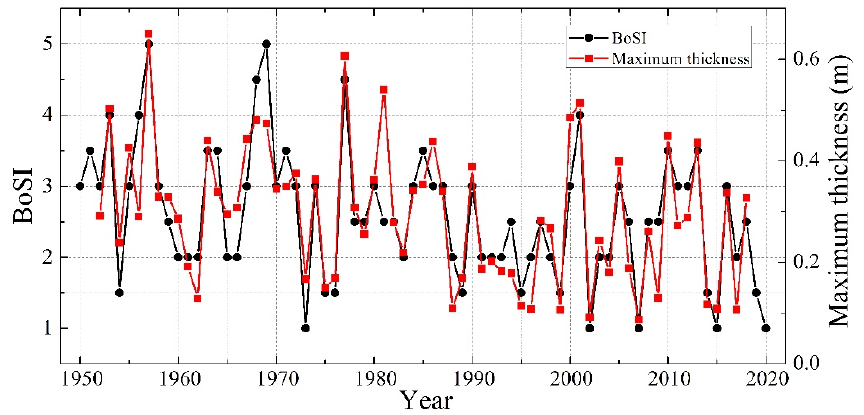
Figure 4. HIGHTSI modeled seasonal maximum ice thickness (black squares) and the Bohai Sea ice index (BoSI).